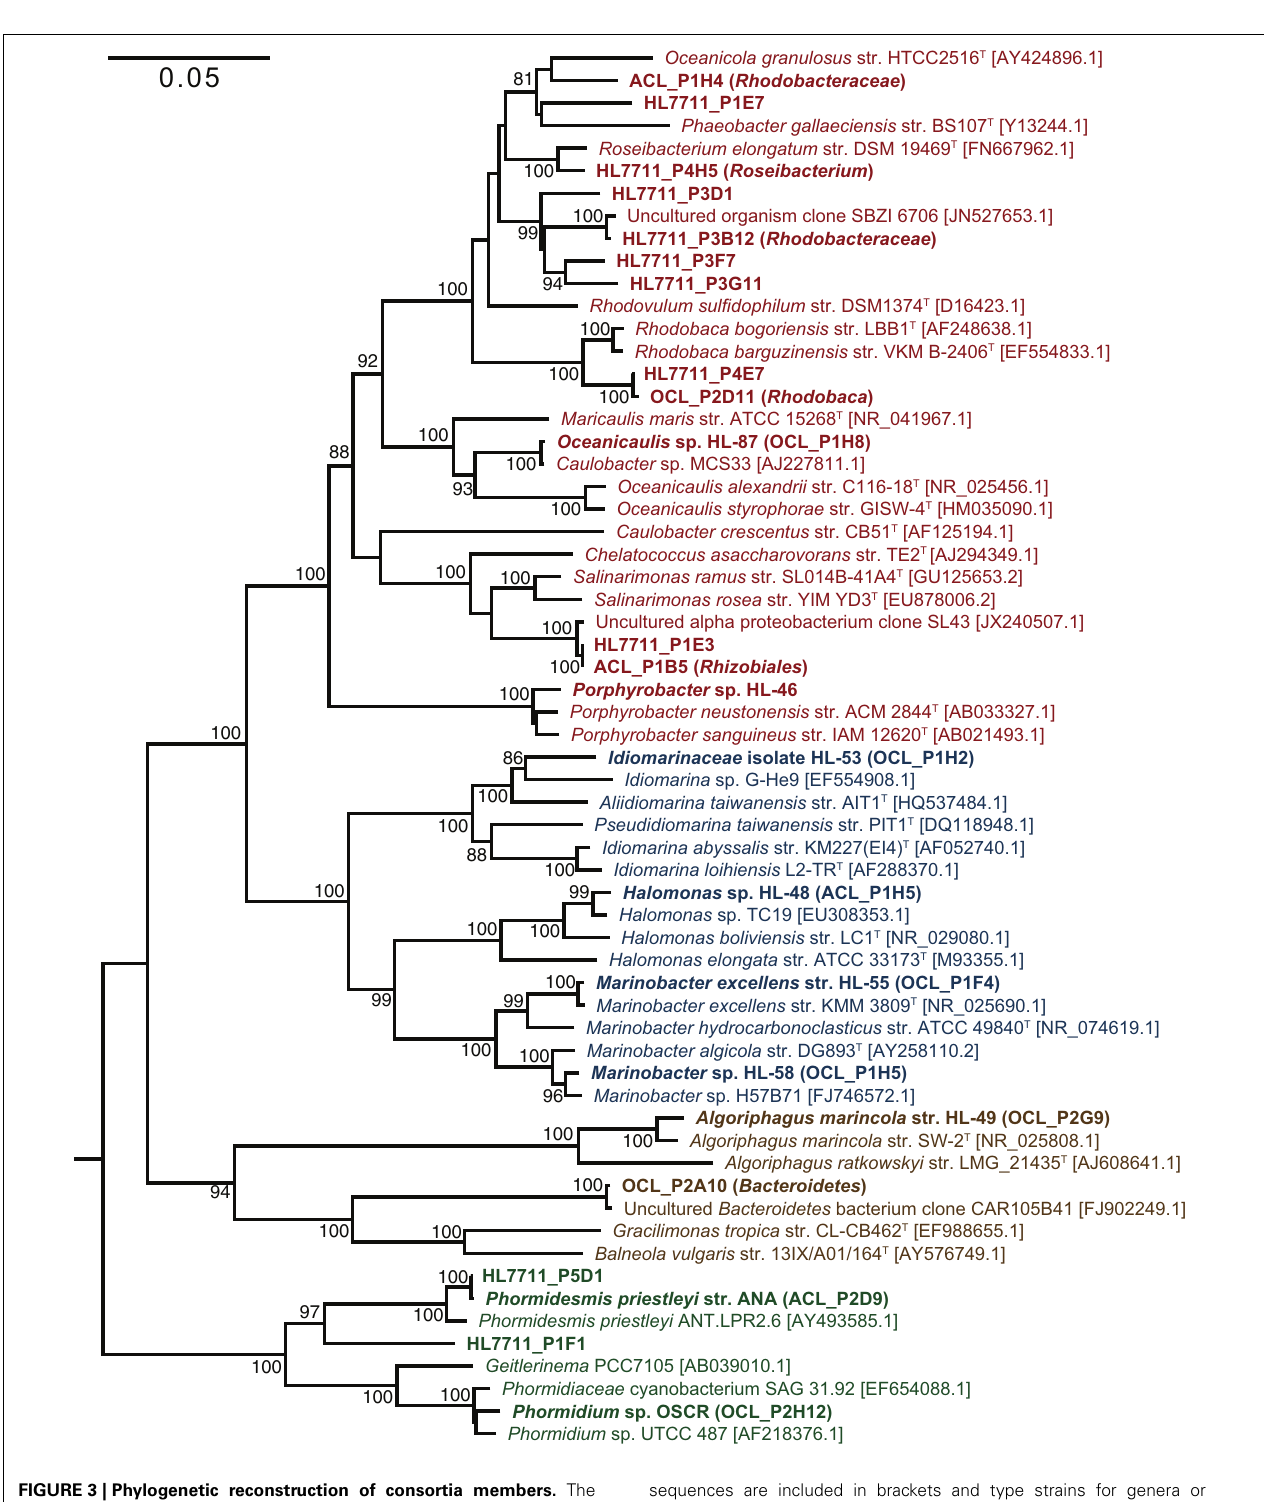
sequences are included in brackets and type strains for genera or species are denoted by a superscript T. Bootstrap values (1000 replications) exceeding 80% are indicated next to the node. A maximum-likelihood reconstruction of the phylogeny displayed the same topology as the one depicted. Clades are colored as follows: Alphaproteobacteria , red; Gammaproteobacteria ; blue, Cyanobacteria , green; and Bacteroidetes ,